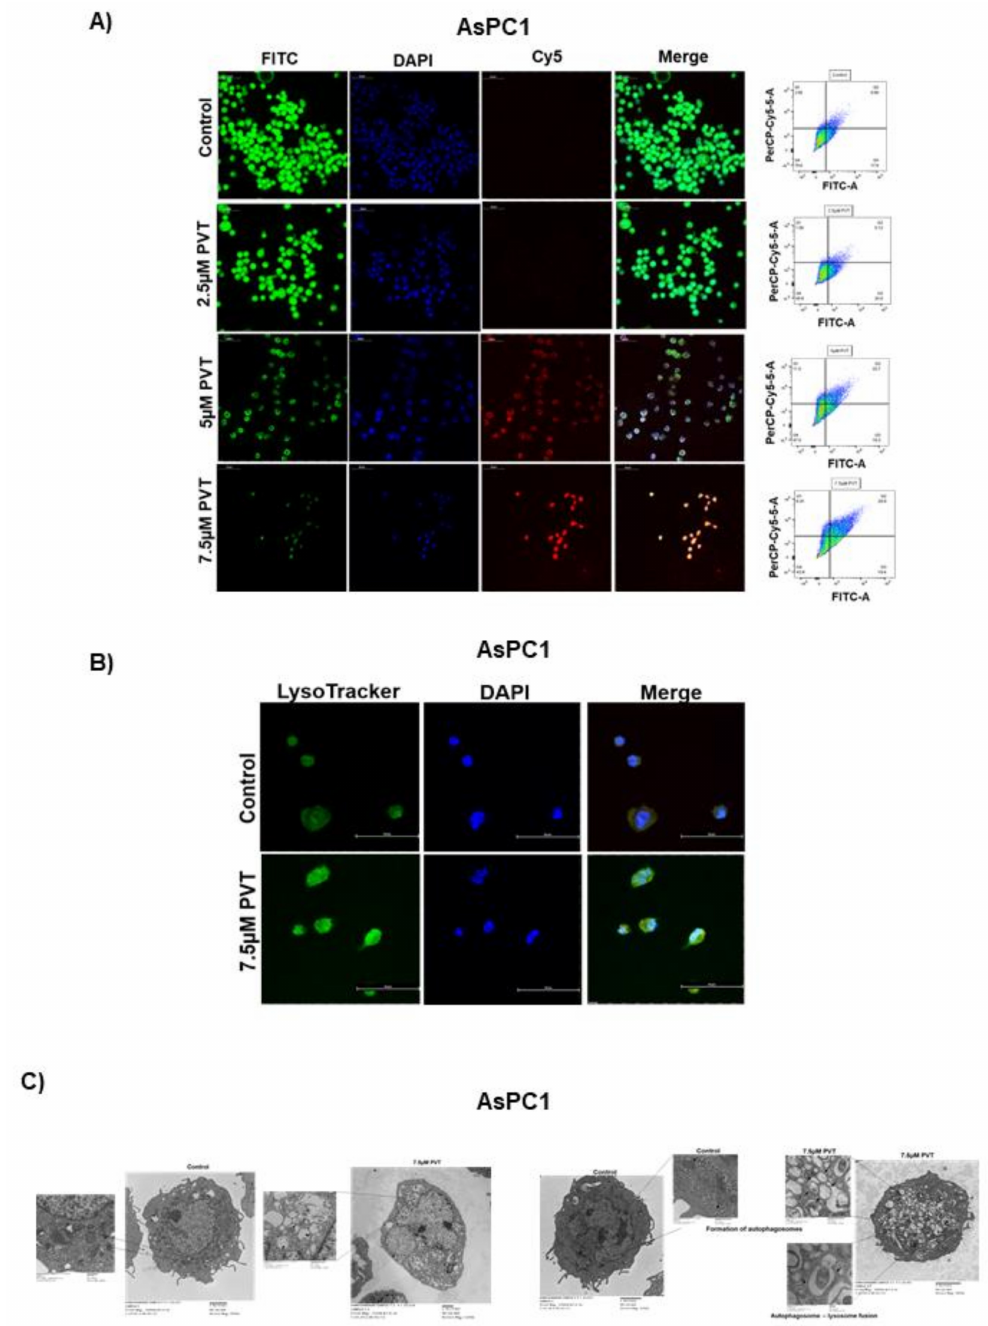
Figure 2. PVT treatment induces autophagosome formation, lysosomal acidification, and fusion of autophagosome with lysosome. ( A ) Autophagy induction by PVT treatment was confirmed by confocal microscopy in AsPC1 cells. ( B ) Localization of acidic lysosomes was confirmed by LysoTracker assay in AsPC1 cells treated with 7.5 µ M PVT. ( C ) Electron microscopic images of control and PVT treated AsPC1 cells showing effect of PVT on autophagosome formation and autophagosome—lysosome fusion. Statistically significant when compared with that of